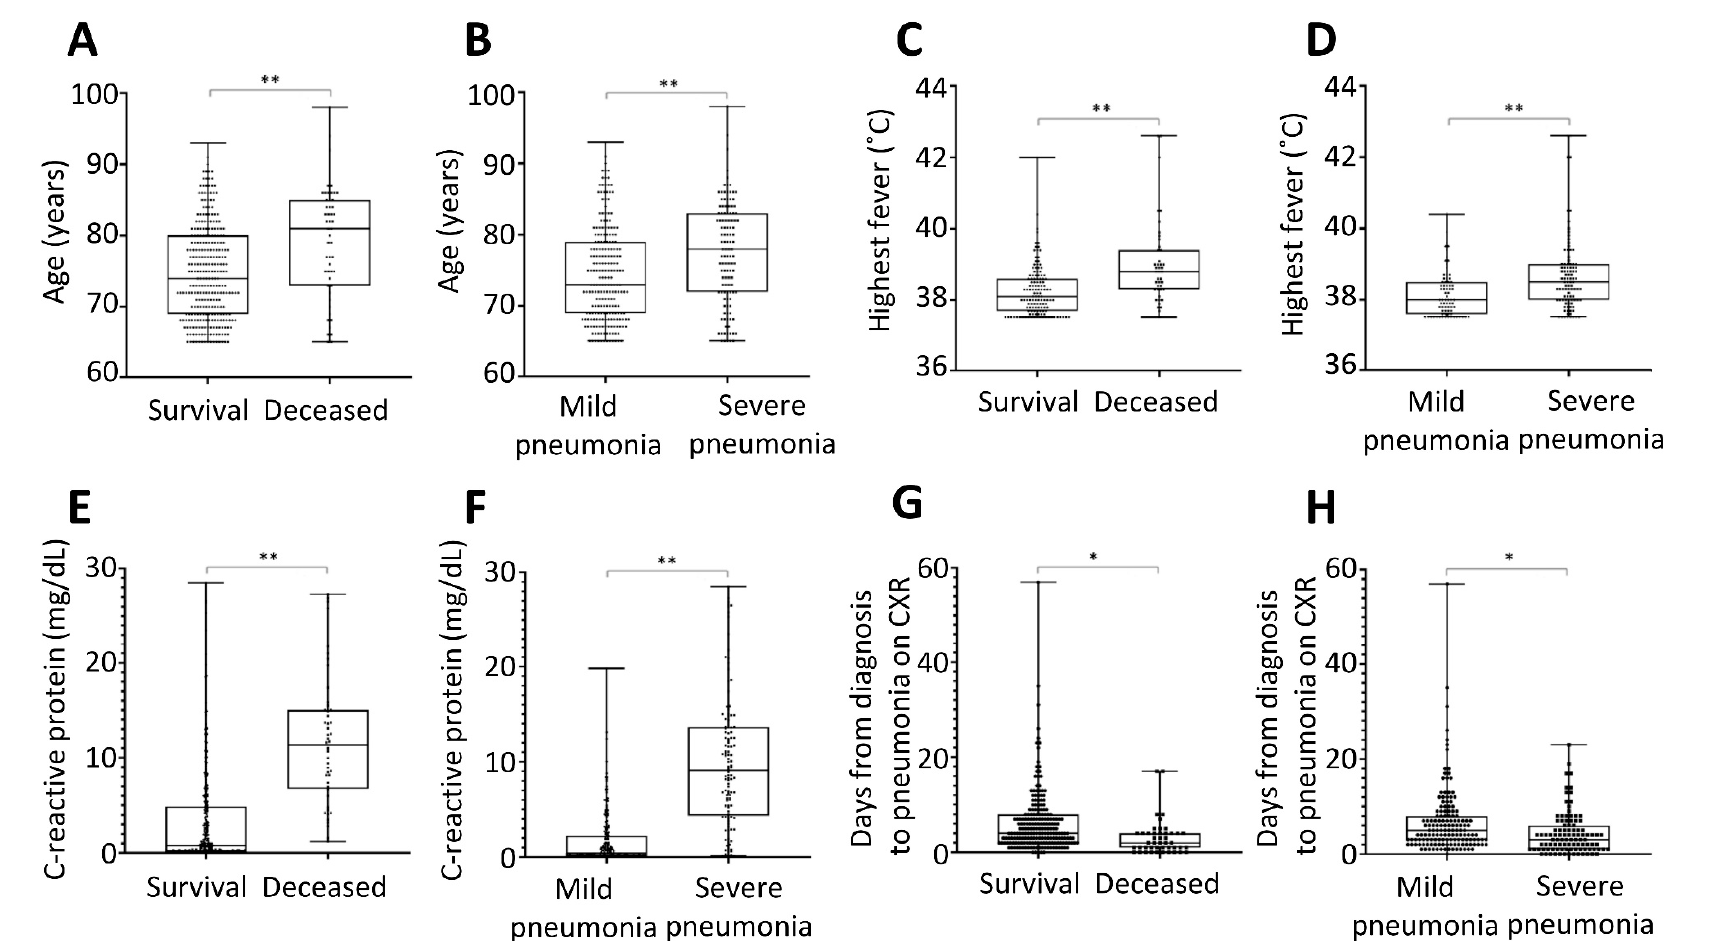
Figure 1. Potential predictors associated with poor prognosis in elderly patients with COVID-19 infection. The age, highest fever, C-reactive protein, and days from diagnosis to pneumonia on chest X-ray were significantly associated with poor outcomes, including death ( A , C , E , G ) and severe pneumonia ( B , D , F , H ). * p < 0.05; ** p < 0.001.